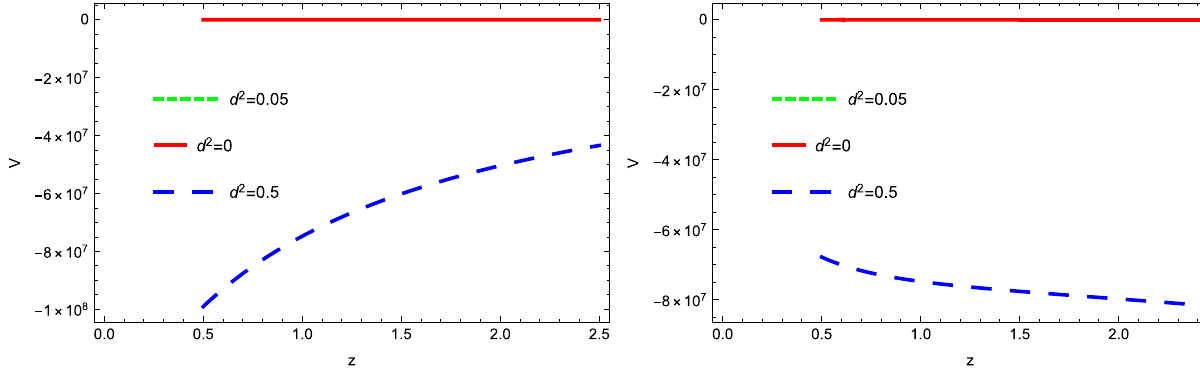
Fig. 26 Plot of V verses z for u = 1 and u = 2 . 002 for K-essence scalar field model